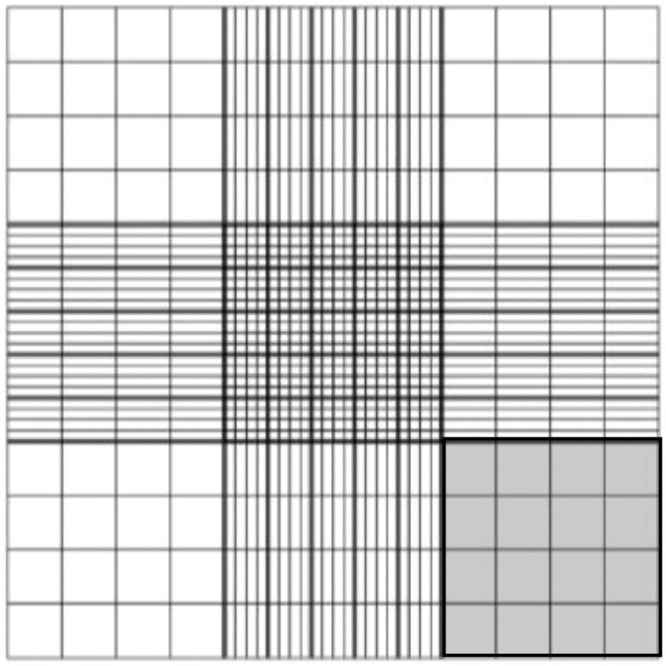
Example of hemocytometer grid. The shaded area indicates one “square.”.